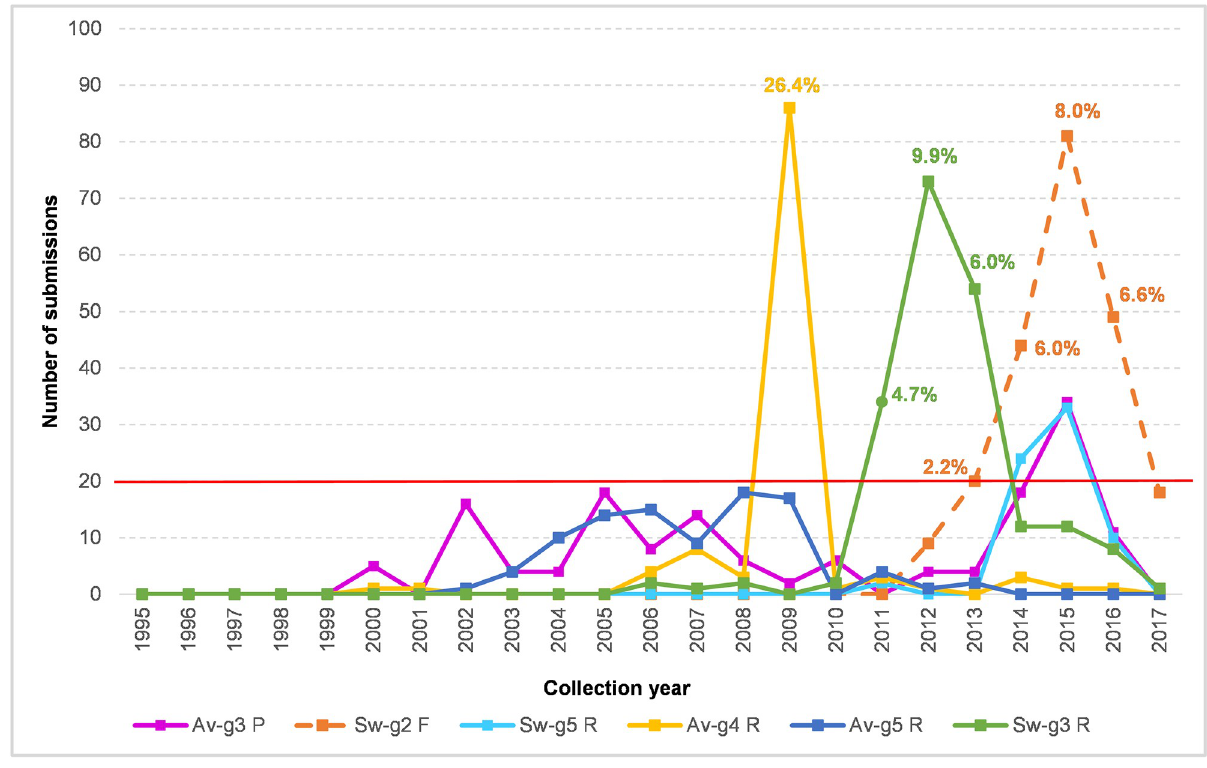
Fig 3. Temporal distribution chart of the critical ROI